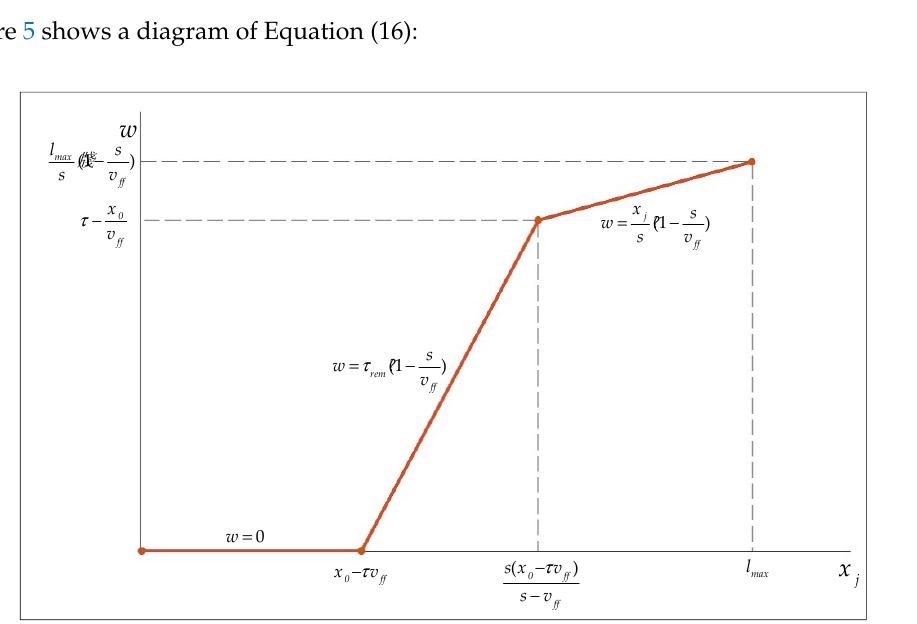
Figure 5. Delay w as a function of x j in Case 1.